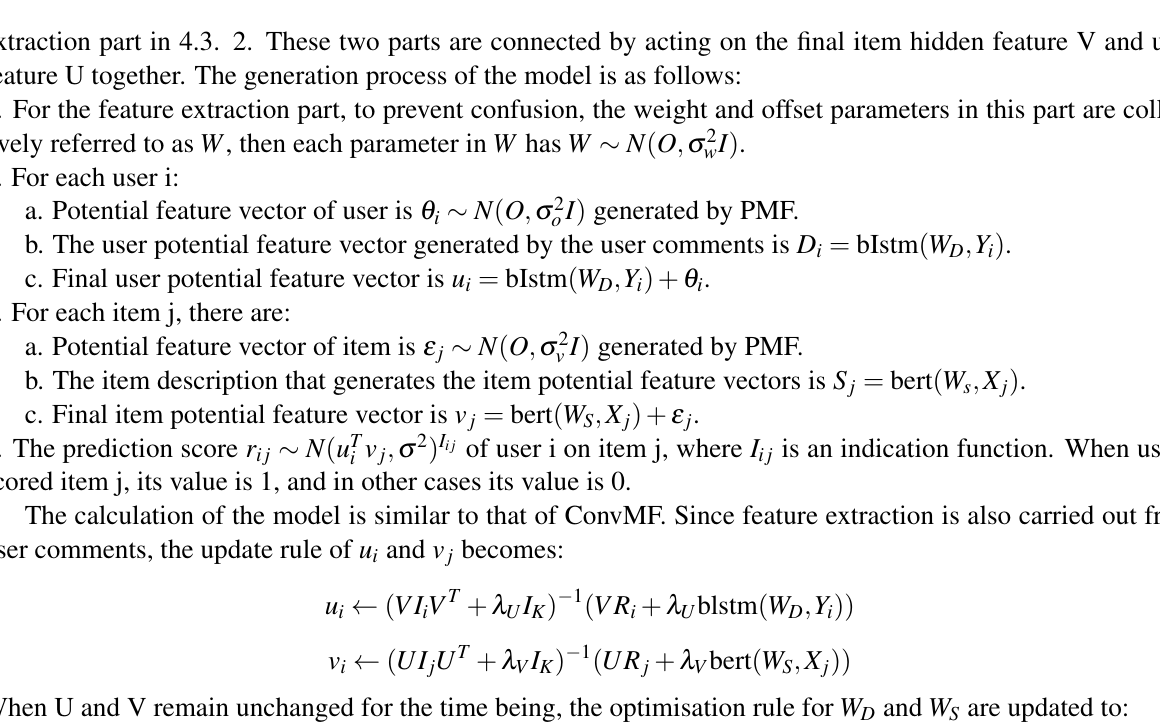
Fig. 5 A recommendation model based on user comments and item